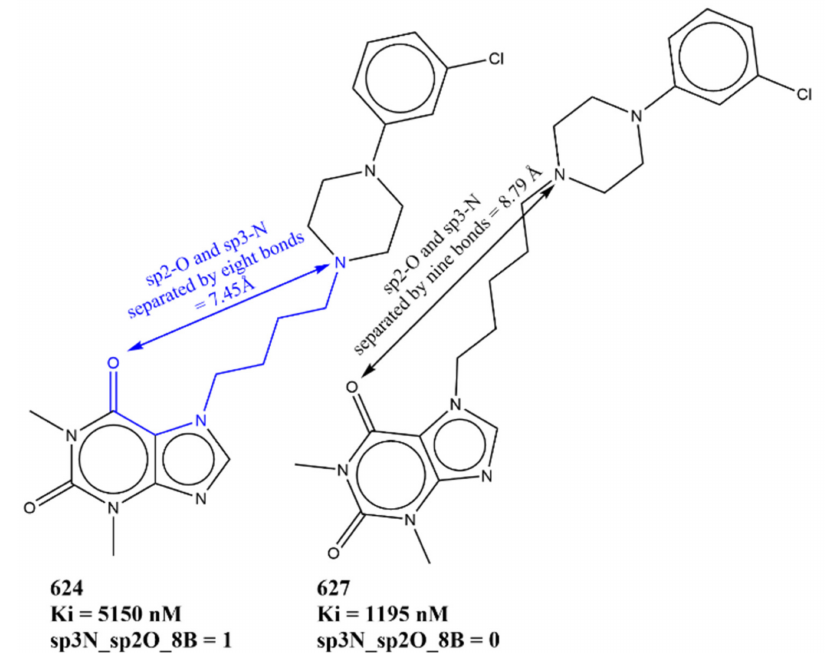
Figure 8. Illustrative examples for representation of sp3N_sp2O_8B.